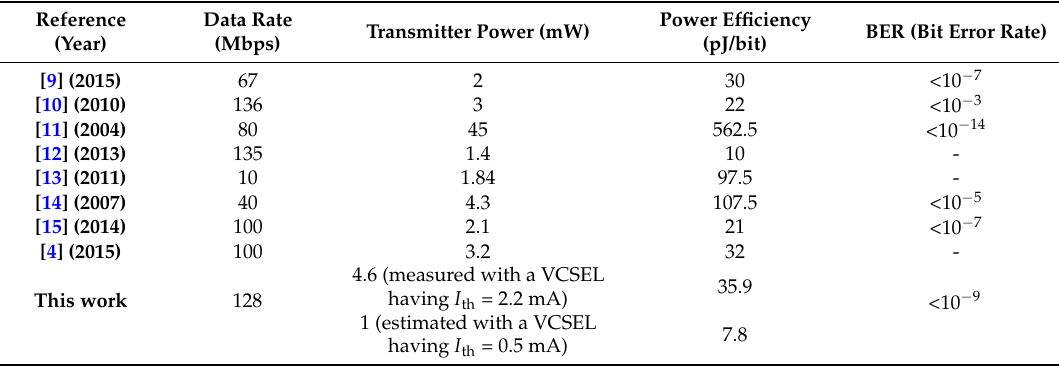
Table 1. Main performances of different biotelemetry